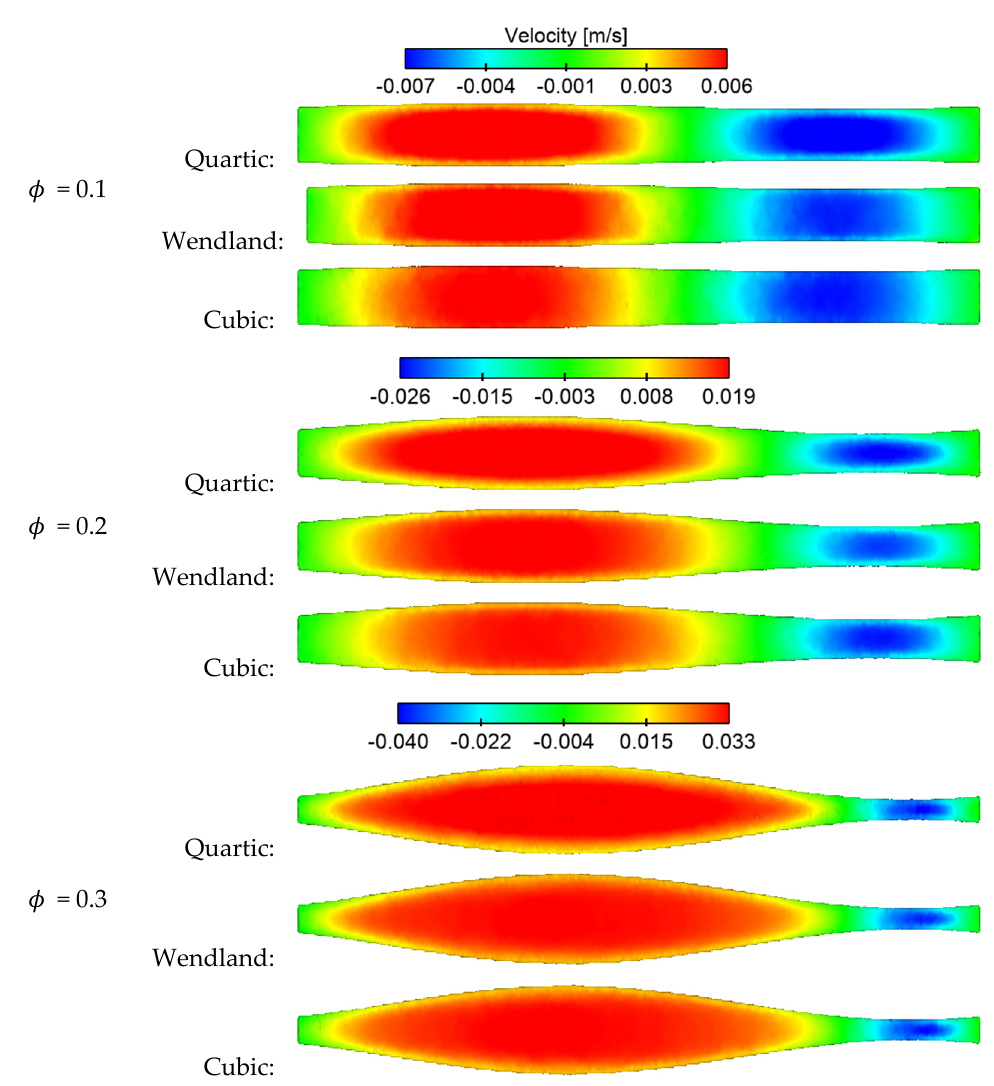
Figure 15. Axial velocity contour at 5 s from the SPH models with different kernels.